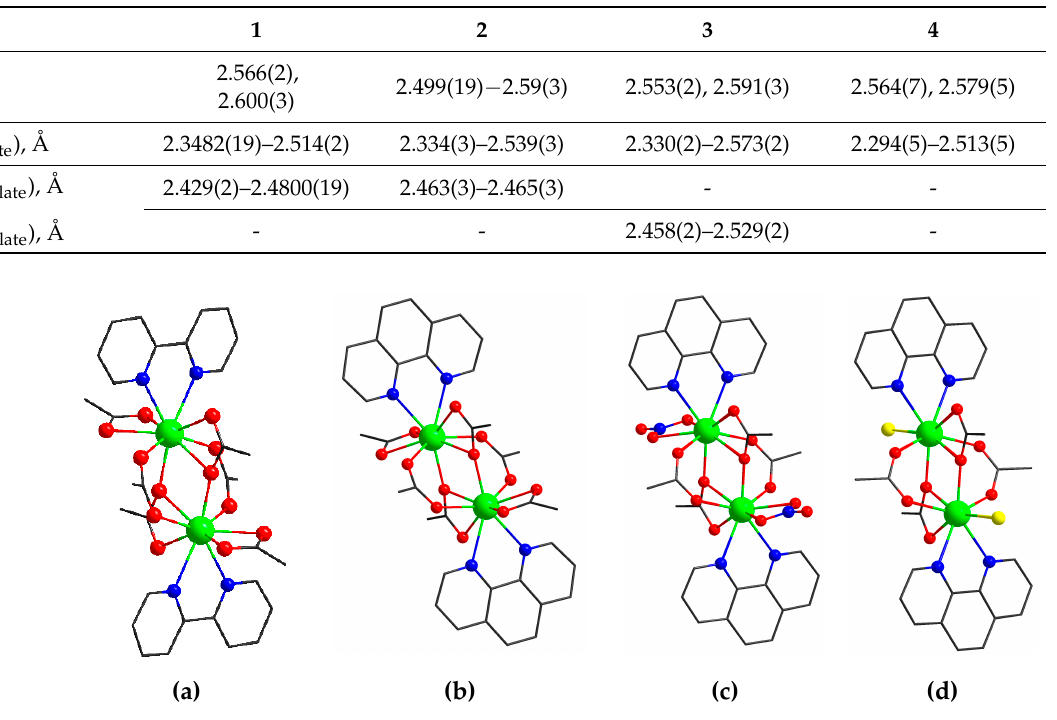
Table 1. Selected bond lengths in the structures 1 – 4 .